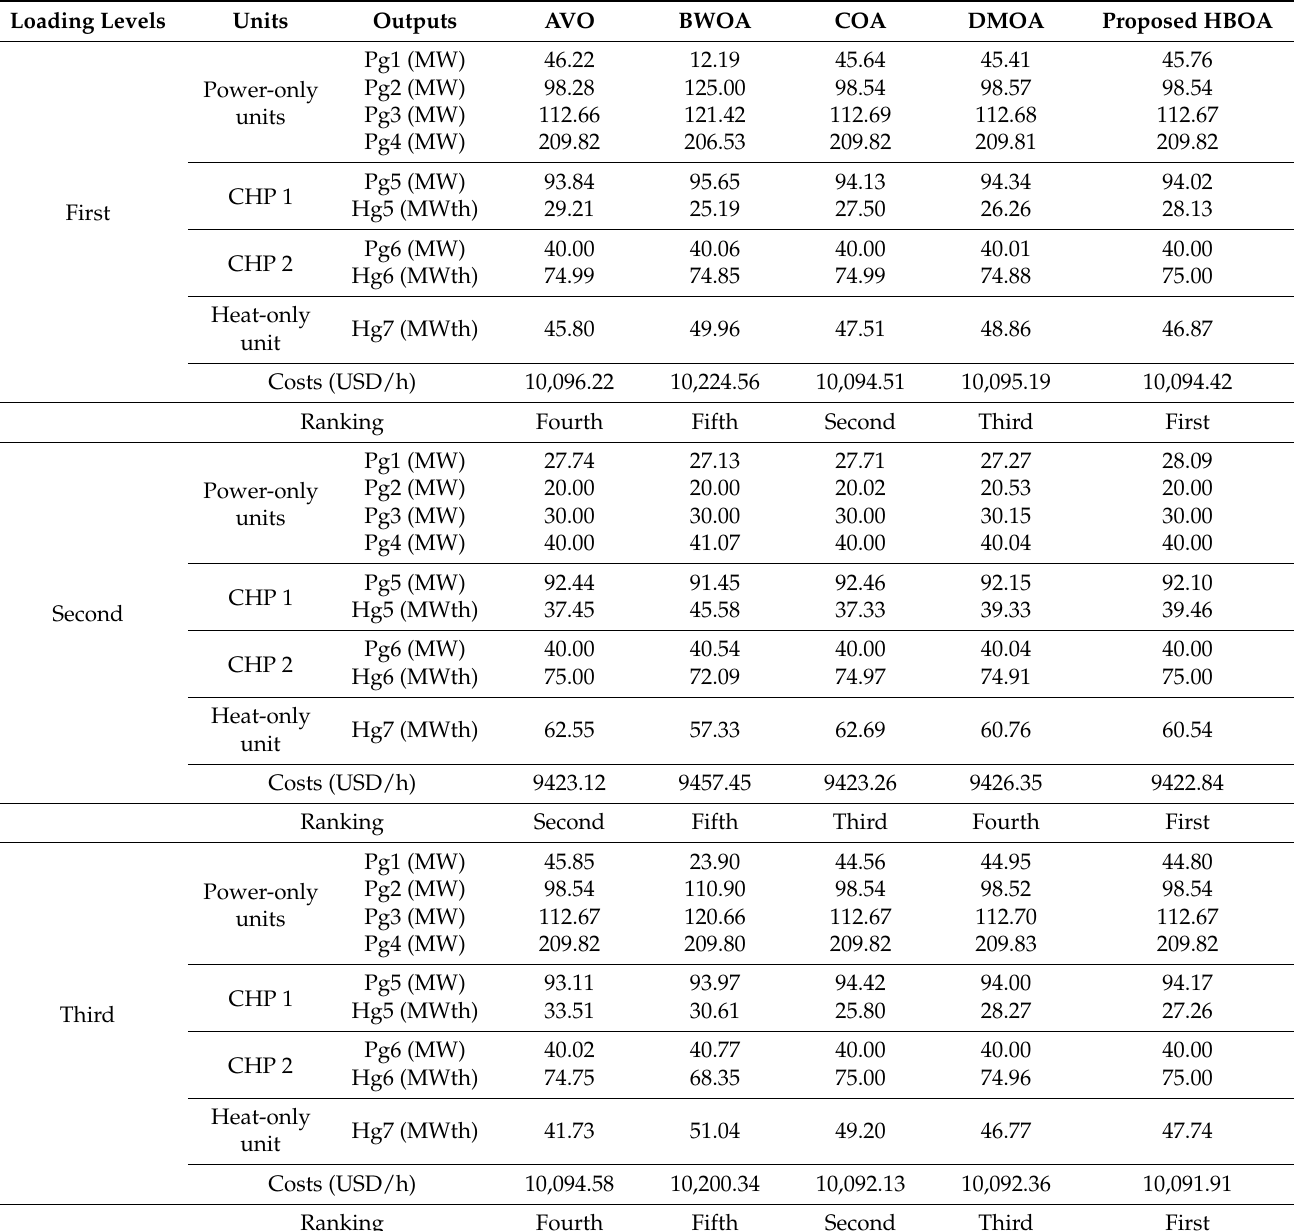
Table 6. Results of the proposed HBOA and the AVO, DMOA, COA, and BWOA of Case